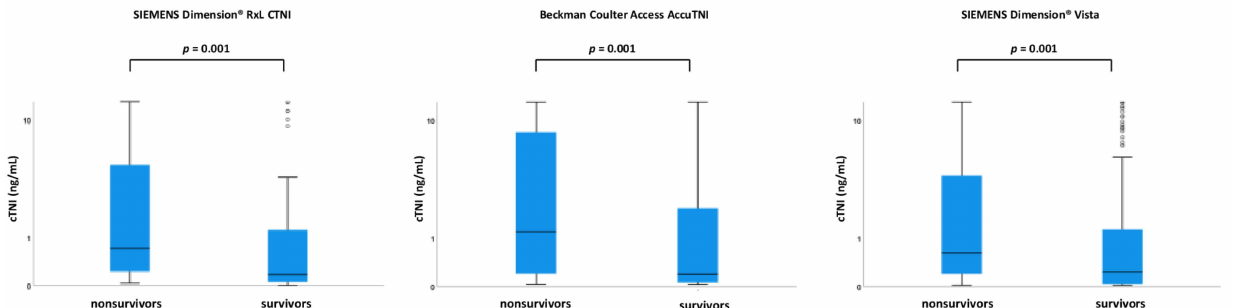
Figure 2. Box plots demonstrating distribution of cTNI levels depending on the applied assay, in patients with ventricular tachyarrhythmias, comparing survivors and nonsurvivors at 30 days. Patients’ characteristics within the entire, unmatched study cohort for the comparison of patients with high vs. low cTNI are outlined within Table 1 (left panel). Patients with high cTNI more frequently presented with VF as compared to patients with low cTNI (62% vs. 47%; p = 0.001). In contrast, cardiovascular risk factors and LVEF were equally distributed in both groups. Rates of CPR were higher in patents with elevated cTNI (70% vs. 49%; p = 0.001). Furthermore, patients with high cTNI were more frequently treated with beta blockers, ACE inhibitors, statins, amiodarone and aldosterone